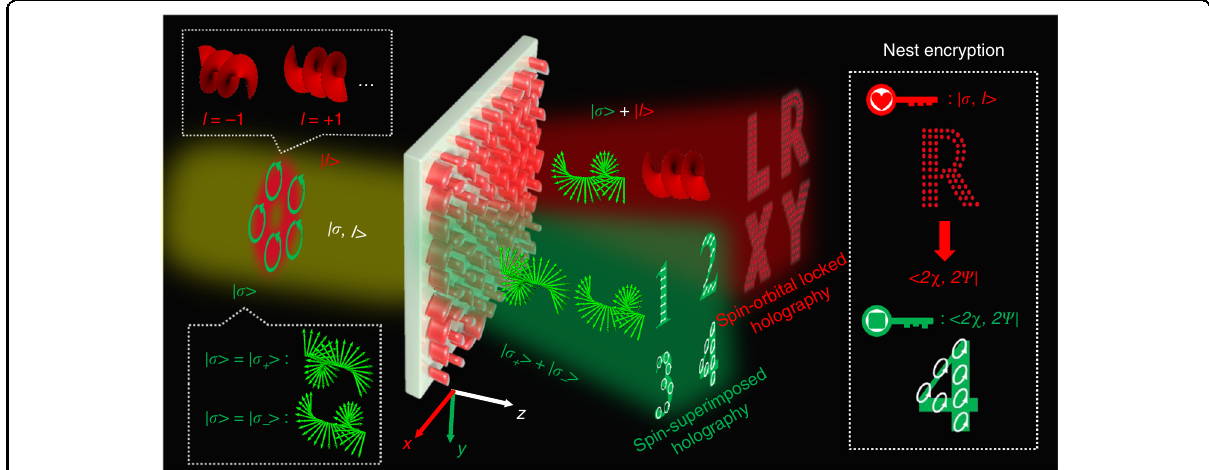
Fig. 1 Schematic illustration of the AM holography for optical nested encryption. The AM holography depends on arbitrary superimpose the SAM and OAM eigenstates in the output fi eld. For the spin-orbital locked holography (SOLH), the reconstruction of the four holographic images “ L, R, X, Y ” depends on the incident light carrying certain SAM and OAM values (indicated as | σ , l >). For the spin-superimposed holography (SSH), the four Arabic numbers “ 1, 2, 3, 4 ” with speci fi c spatially distributed SoPs are reconstructed under the incident XLP Guassian light (indicated as |0, 0 >). For the optical nested encryption, the reconstructed SOL holographic images are used to perform as the keys (translated to certain SoPs represented as <2 χ , 2 ψ | , where χ and ψ indicate the ellipticity angle and azimuth angle, respectively.) of the next decryption and the encrypted information is fully unlocked by the generated SS holographic